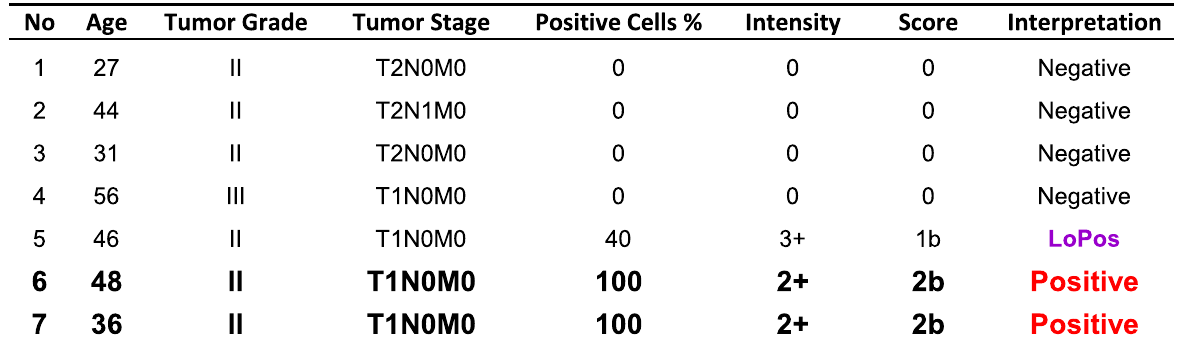
Table 4 Group II, summary of cases with adenosquamous carcinoma and tumor cell PD-L1 reactions with the final scoring as described in this study